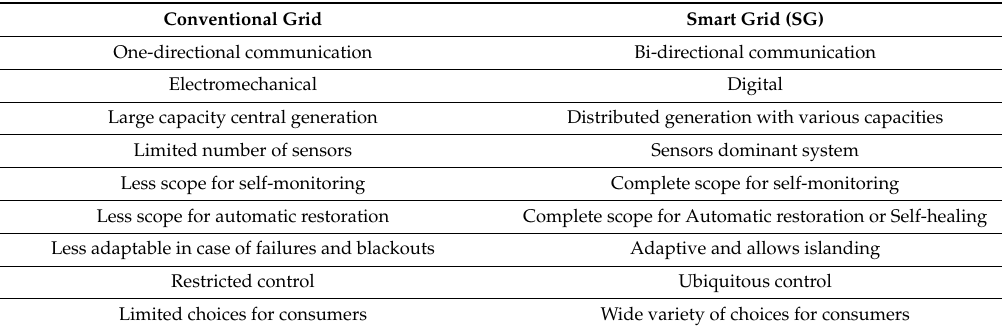
Table 1. Conventional and SG comparison